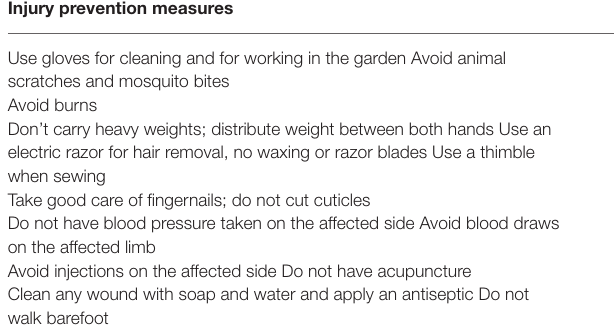
TABLE 1 | Injury prevention